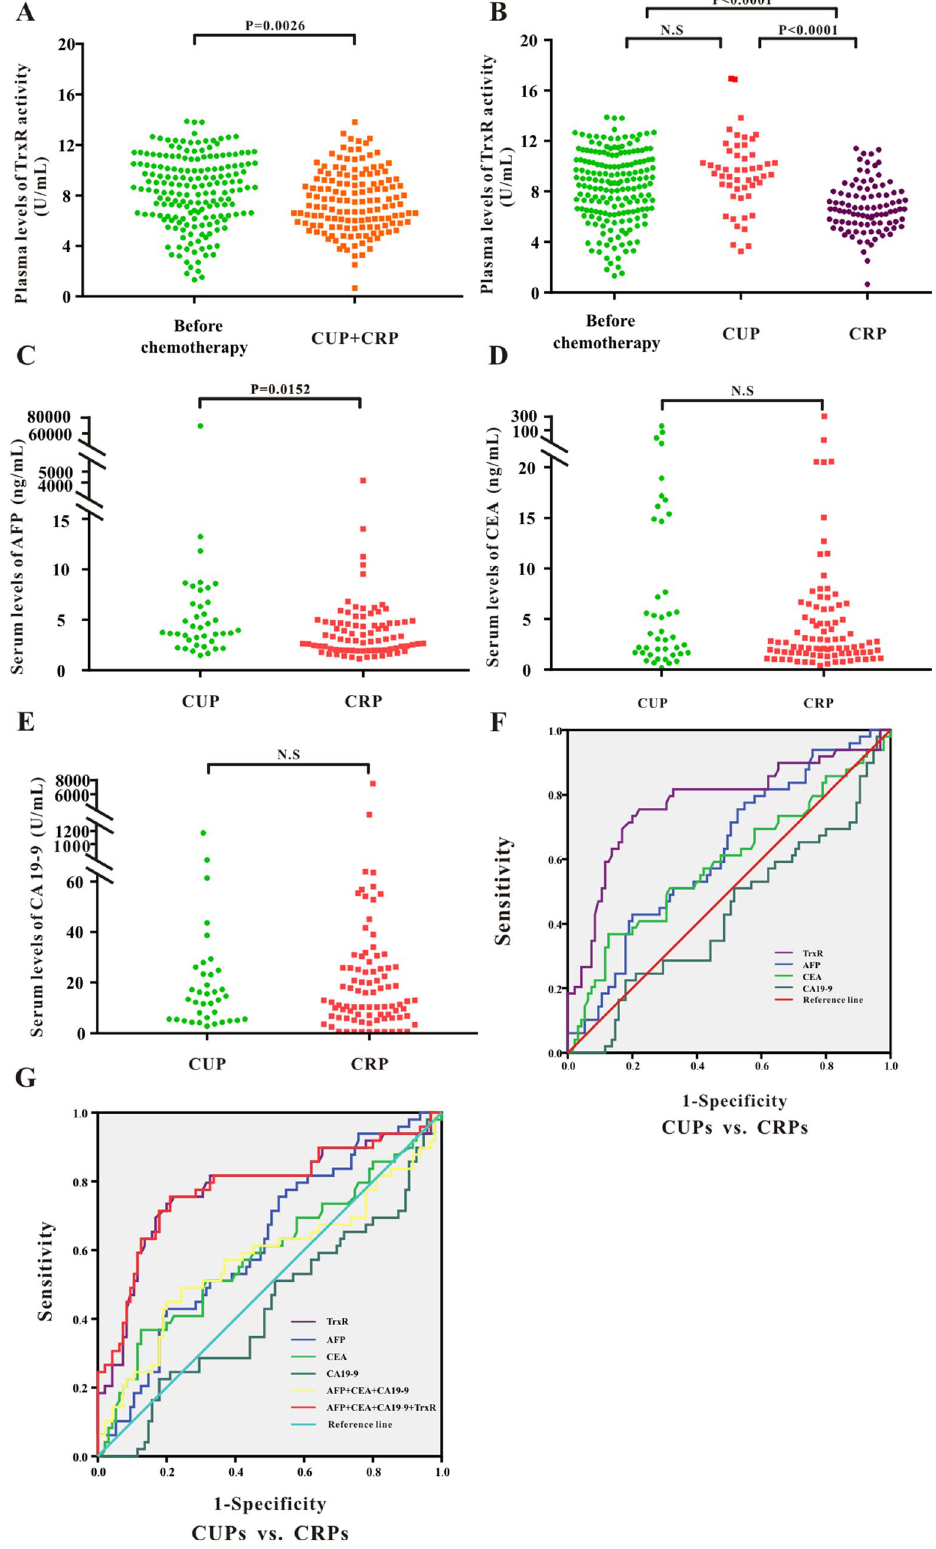
Figure 3. ( A ) Scatter plot of the distribution of plasma TrxR activity levels between liver cancer patients before clinical interventions and PLC patients after chemotherapy. ( B – E ) Scatter plot of the distribution of plasma TrxR ( B ), serum AFP ( C ), CEA ( D ), and CA19-9 ( E ) among PLC patients with different clinical outcome after chemotherapy (CUP vs. CRP). CUP: clinical unresponsive patient; CRP: clinical responsive patients. P values were determined by the Mann–Whitney U test. N.S: no statistical significance. ( F – G ) ROC curve analyses of TrxR, AFP, CEA, CA19-9 ( F ), and the combinations ( G ) for the differentiation of PLCs with different clinical outcome after chemotherapy (CUP vs.